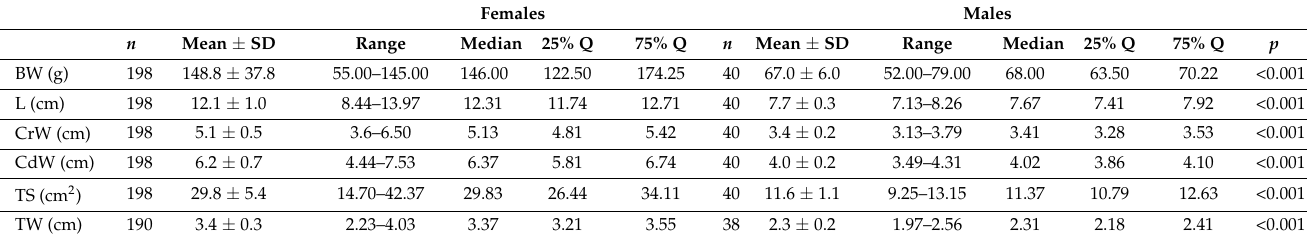
Table 1. Body weight and measurements of adult Xenopus laevis grouped according to sex.